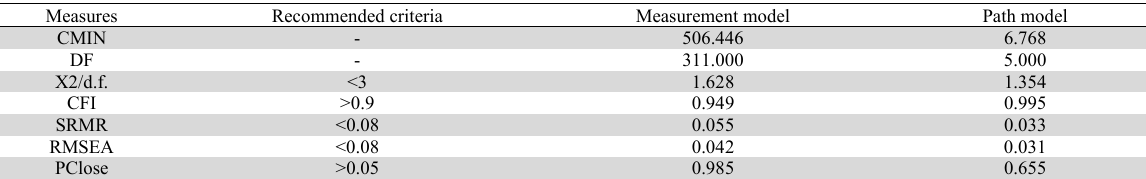
Model fit measures